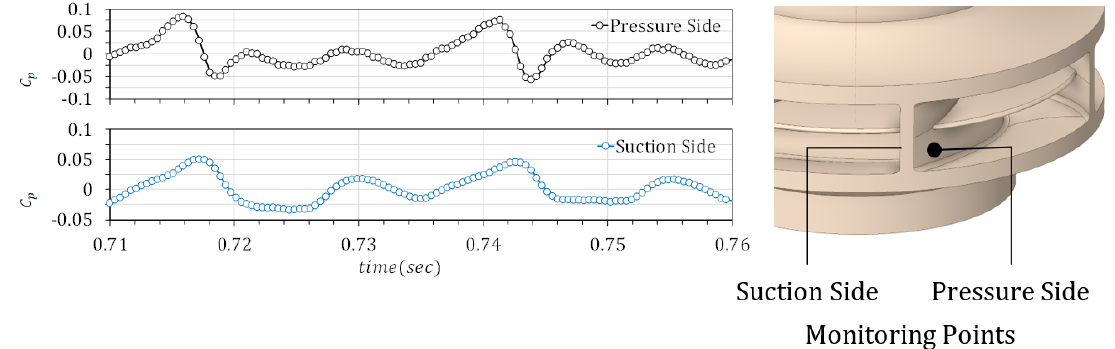
Figure 19. Time history plot of normalized pressure coefficient, 𝑐 𝑝 , on monitoring points on the blade’s surface.